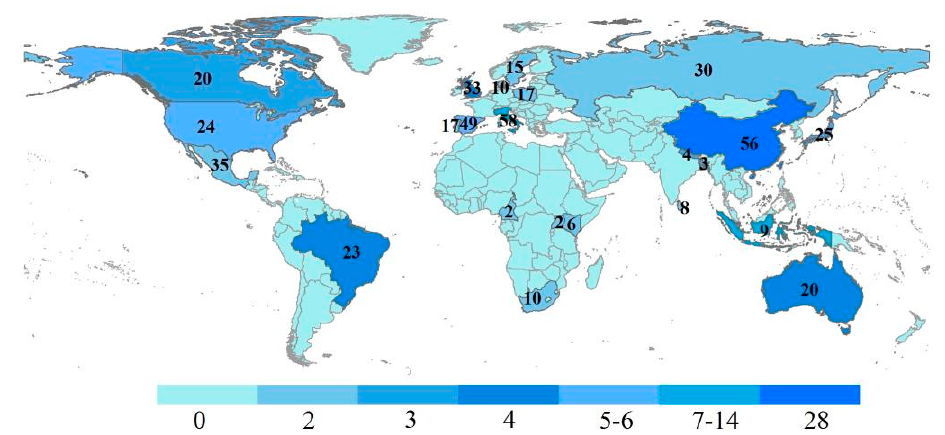
Figure 6. Research regions distribution of literatures and the number of WH owned by the States Parties.